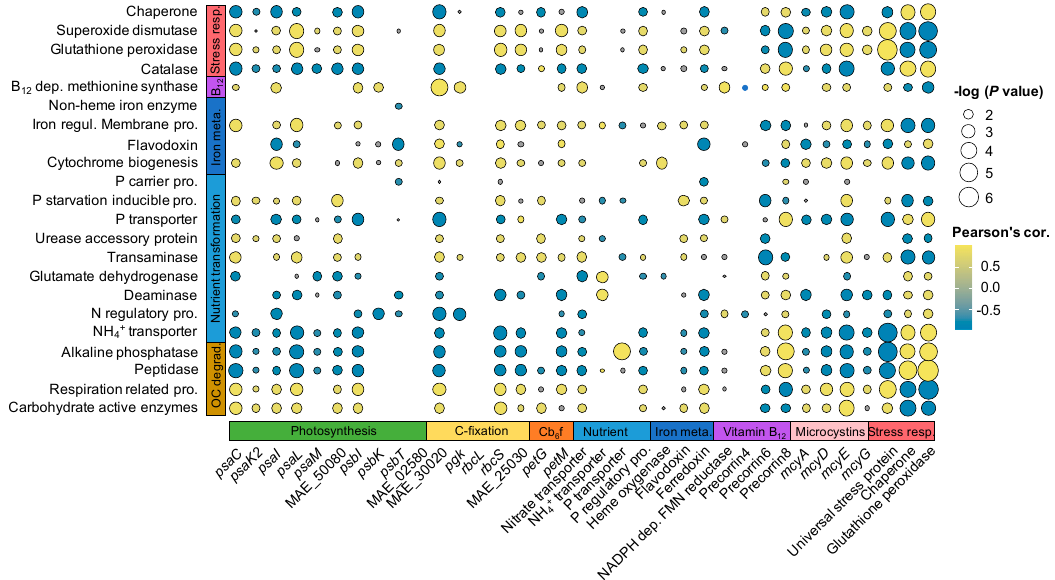
Figure 5. Correlations between Microcystis genes (X-axis) and microbiome genes (Y-axis). Only correlations with adjusted p < 0.05 are